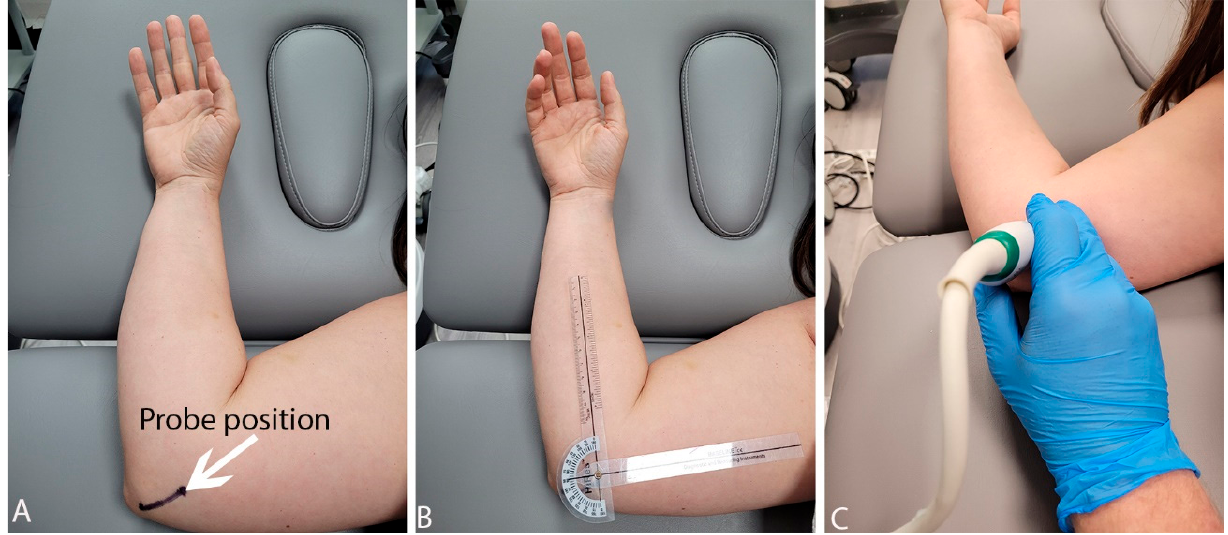
Figure 1. Probe position ( A ), control of the position of the elbow joint ( B ) and examination phase ( C